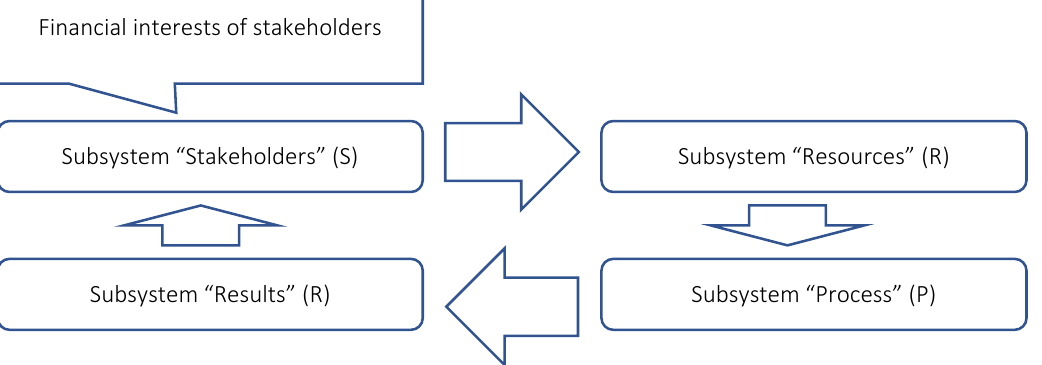
Figure 1. Enterprise as an SRPR